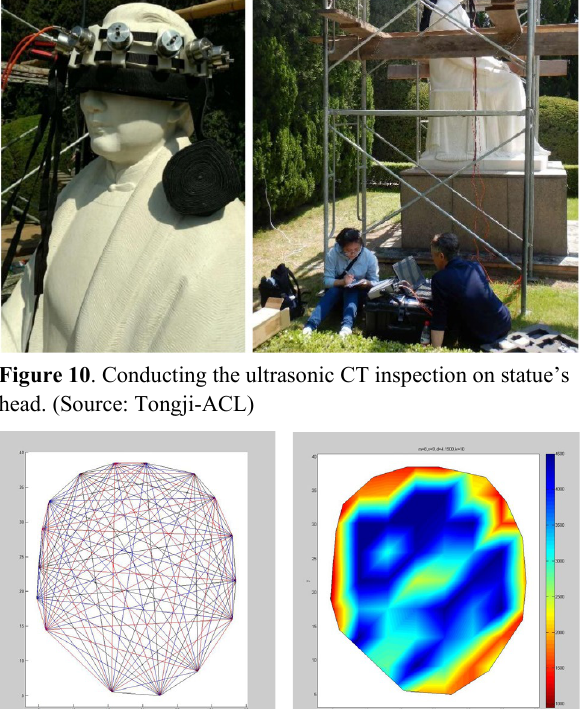
Figure 9 . Under the in-situ portable microscope: cracks and bird droppings pollution. (Source: Tongji-ACL)